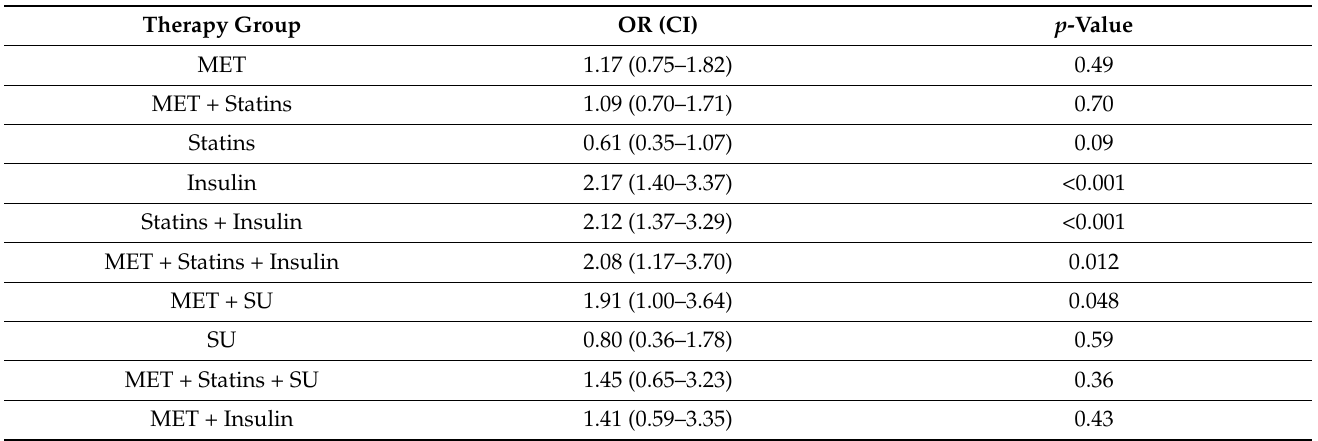
Table 3. Sex-specific regression results for models with female patients only. MET = metformin, SU = sulfonylureas, OR = odds ratio, CI: confidence